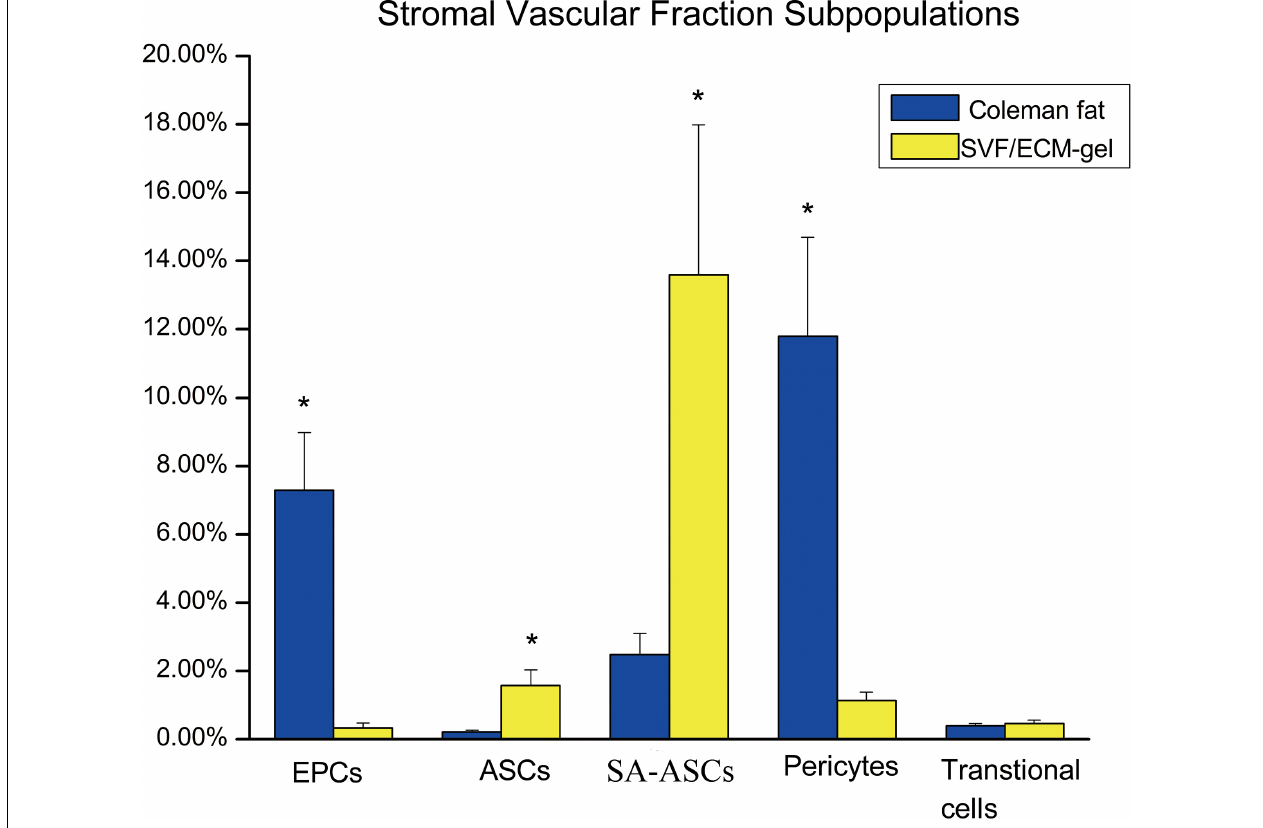
FIGURE 8 | Flow cytometry of the proportions of stem cell subsets in the suspension of SVF cells from the two fat grafts. ASC, adipose-derived stem cell; EPS, endothelial progenitor cell. * P <